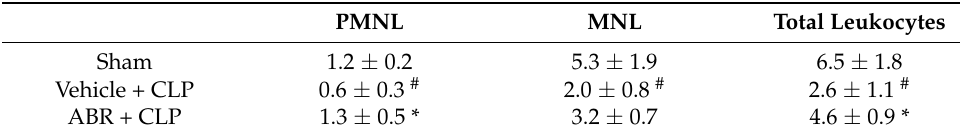
Figure 5. S100A9 regulates systemic inflammation. Mice were pre-treated with intraperitoneal injections of the vehicle or ABR-238901 (10 mg/kg) 1 h before Sham or CLP operation. Levels of ( A ) CXCL-1, ( B ) CXCL-2 and ( C ) IL-6 in plasma were determined 24 h after CLP induction. Data are presented as box plots with median (25–75 percentile) and the whiskers extend from the minimum to the maximum levels and dots represent sample values. # p < 0.05 vs. Sham, and * p < 0.05 vs. Vehicle, n = 5. Table 1. Systemic leukocyte counts.